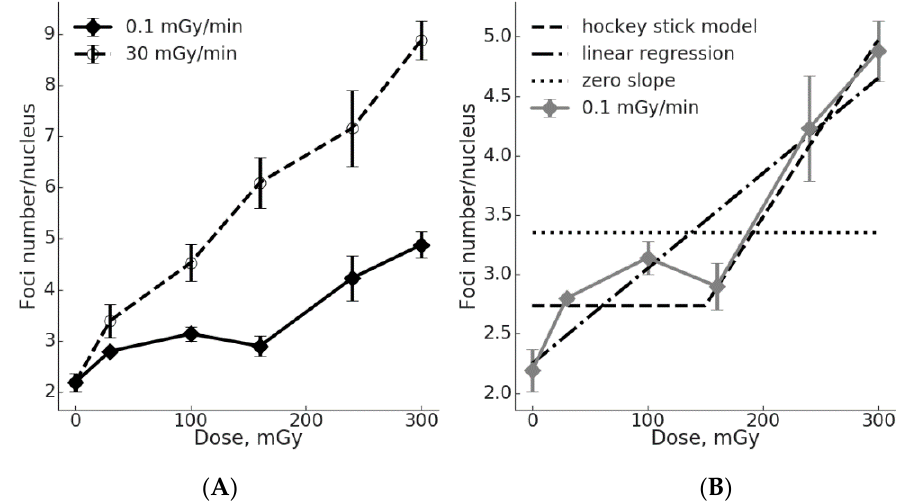
Figure 1. Dose-effect curves for the γ H2AX foci formation in γ -irradiated MSCs. ( A ) Data generated using either acute or low dose-rate exposure are shown. Mean and SEM of at least three independent experiments are shown on the y -axis. ( B ) Fitting the γ H2AX foci data for chronic exposure using a “hockey stick” model (threshold at 150 mGy), a linear regression with a positive slope or a liner regression with a nil slope. See text for details. regression with a nil slope. See text for